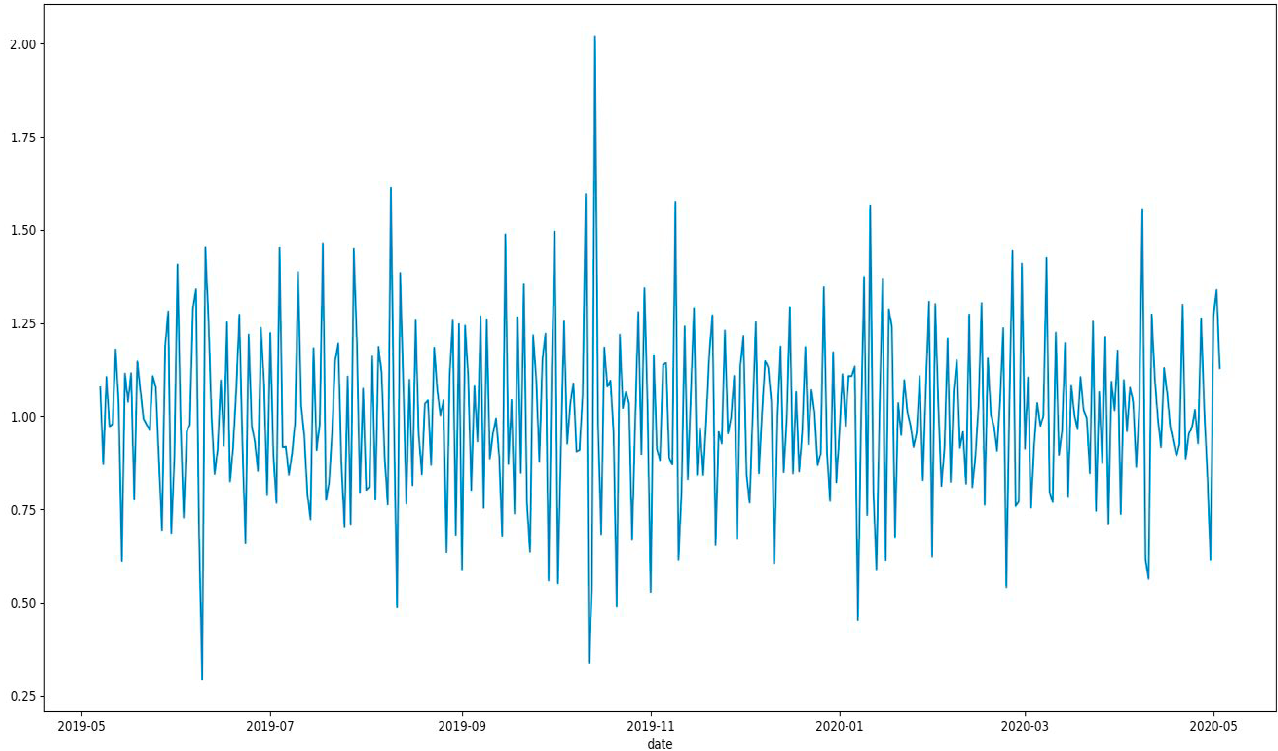
Figure 3. A relative activity graph example of the far-right VKontakte community.